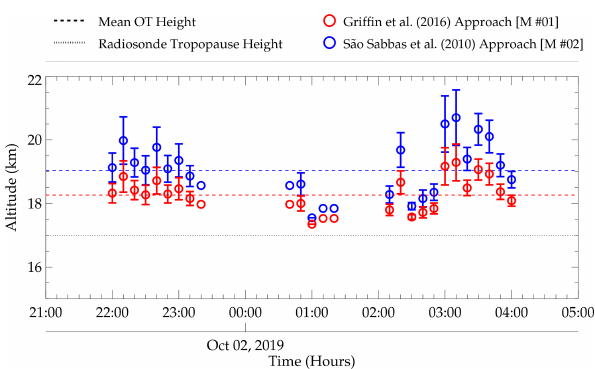
Figure 14. Comparison between the two OT altitude estimation methods. OT altitudes in red circles represent the Griffin et al. (2016) method, whereas the São Sabbas et al. (2010) method is represented by blue circles. The black dotted lines depict the ra- diosonde tropopause height, and the mean OT height is shown by the dashed lines. Red represents the Griffin et al. (2016) method and blue the São Sabbas et al. (2010)